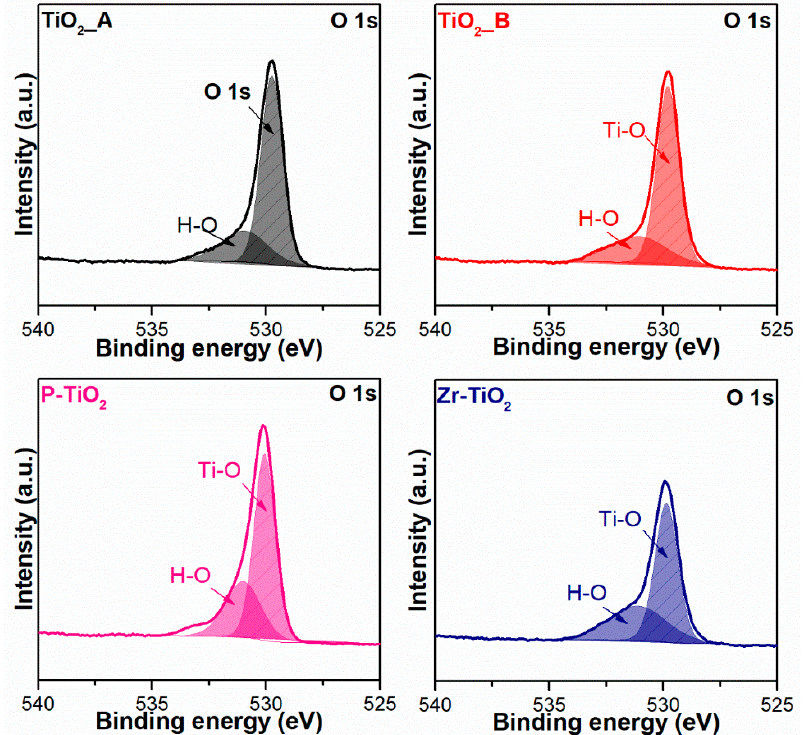
Figure 8. Deconvoluted X-ray photoelectron spectra of the samples in the O 1 s core level.